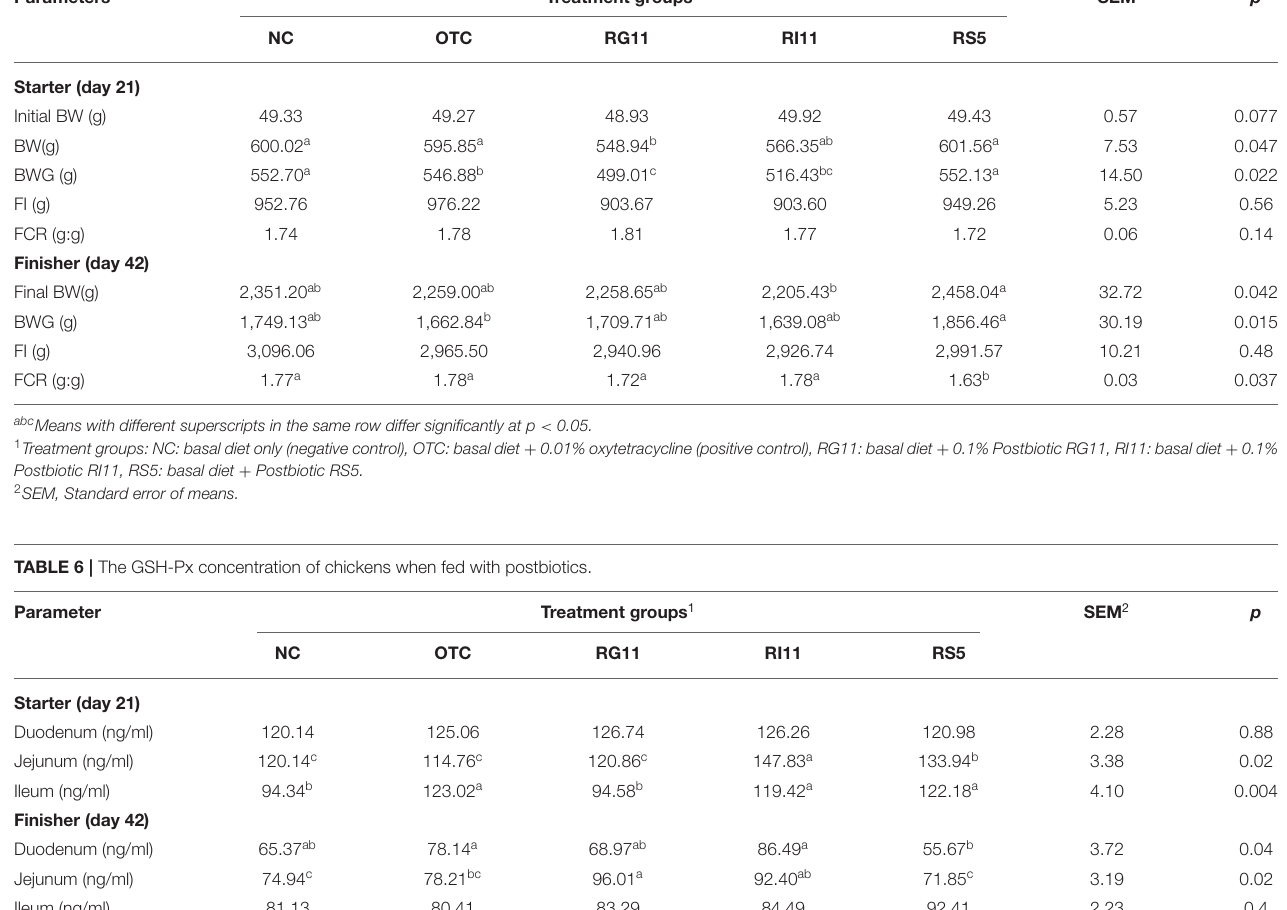
TABLE 5 | Growth performance of chickens when fed with different postbiotics. Parameters